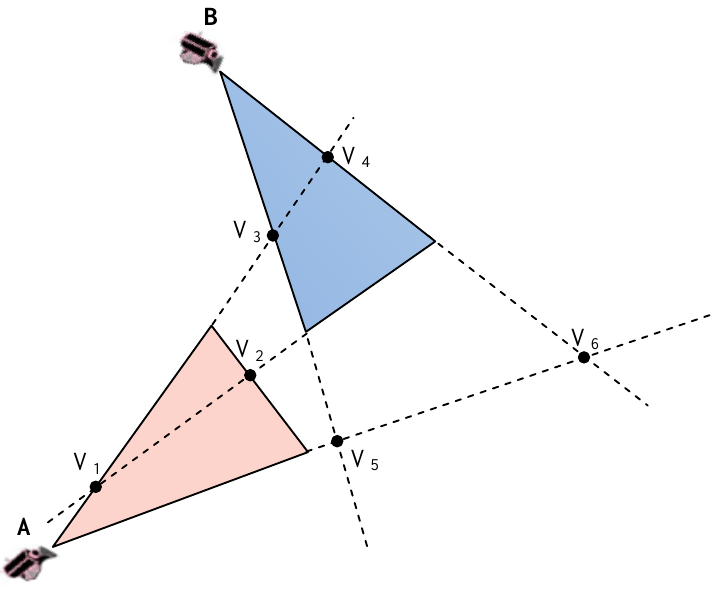
intersect the 1